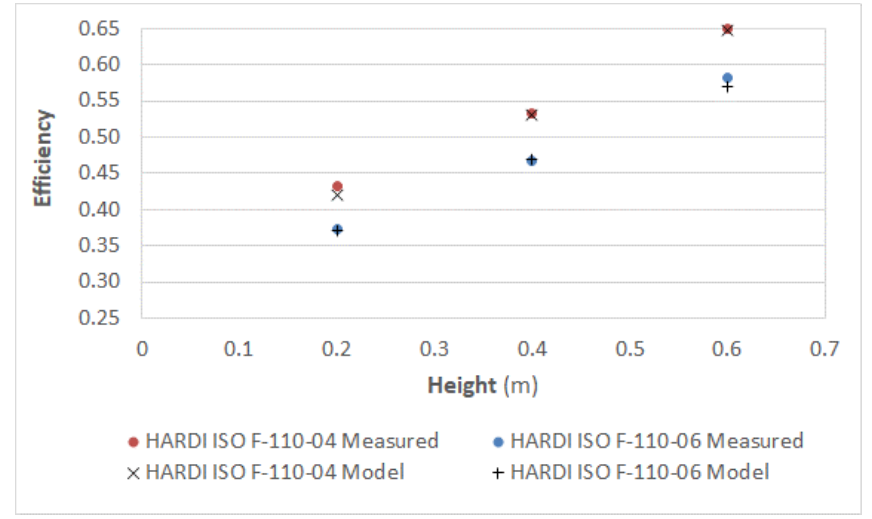
Figure 13. Variation in mean cooling efficiency vs. nozzle height.